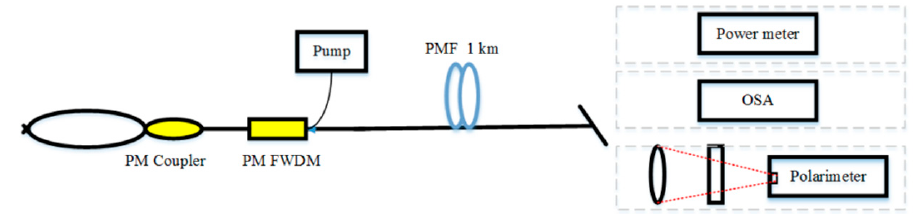
Figure 8. The scheme of all polarization-maintaining fiber (PMF) Raman RFL.